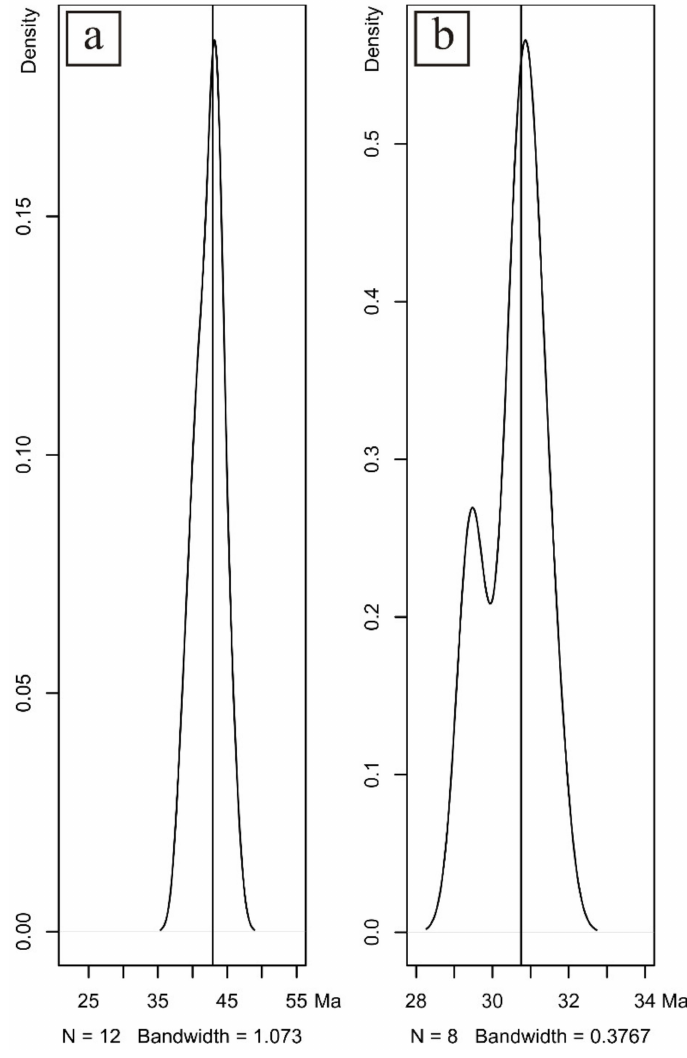
Figure 15. Kernel density distribution for U–Pb data. ( a ) Data from this work, ( b ) data from Vison à et al. [4] from Castelletto di